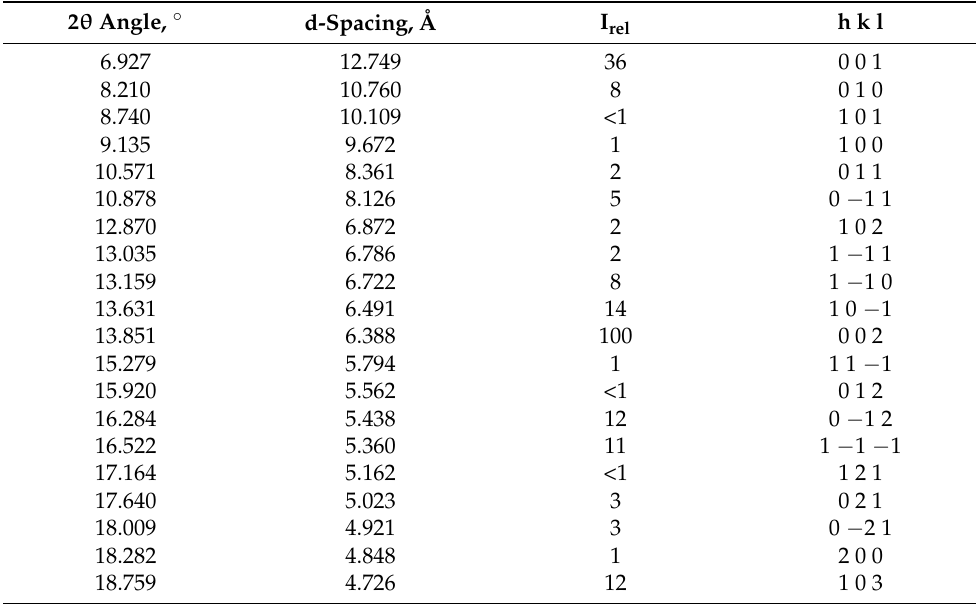
Table 6. List of observed 2 θ angles, d-spacings, and relative intensities, jointly with reflection indices, for Eltrombopag Form X.